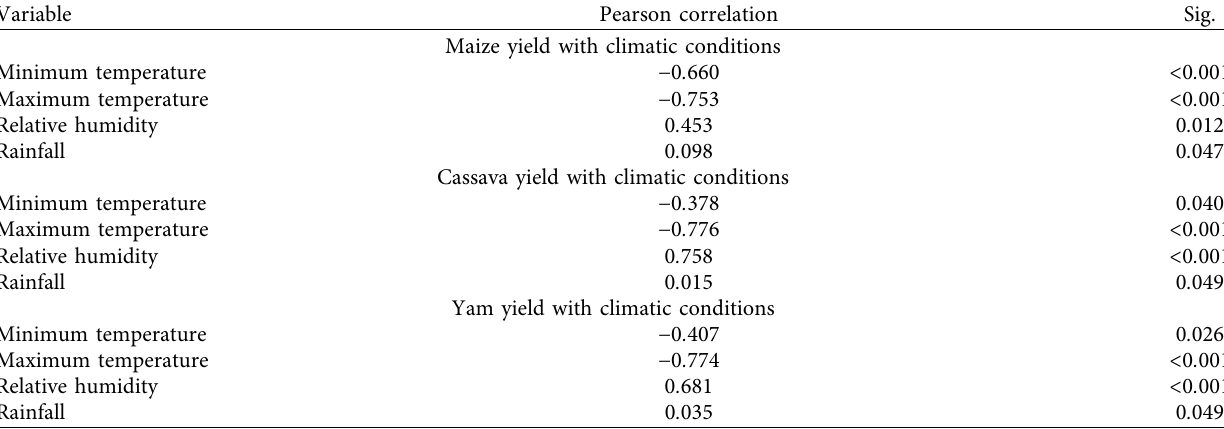
Table 1: Correlation analysis of maize yield, cassava yield, and yam yield with climatic conditions. Variable Pearson correlation